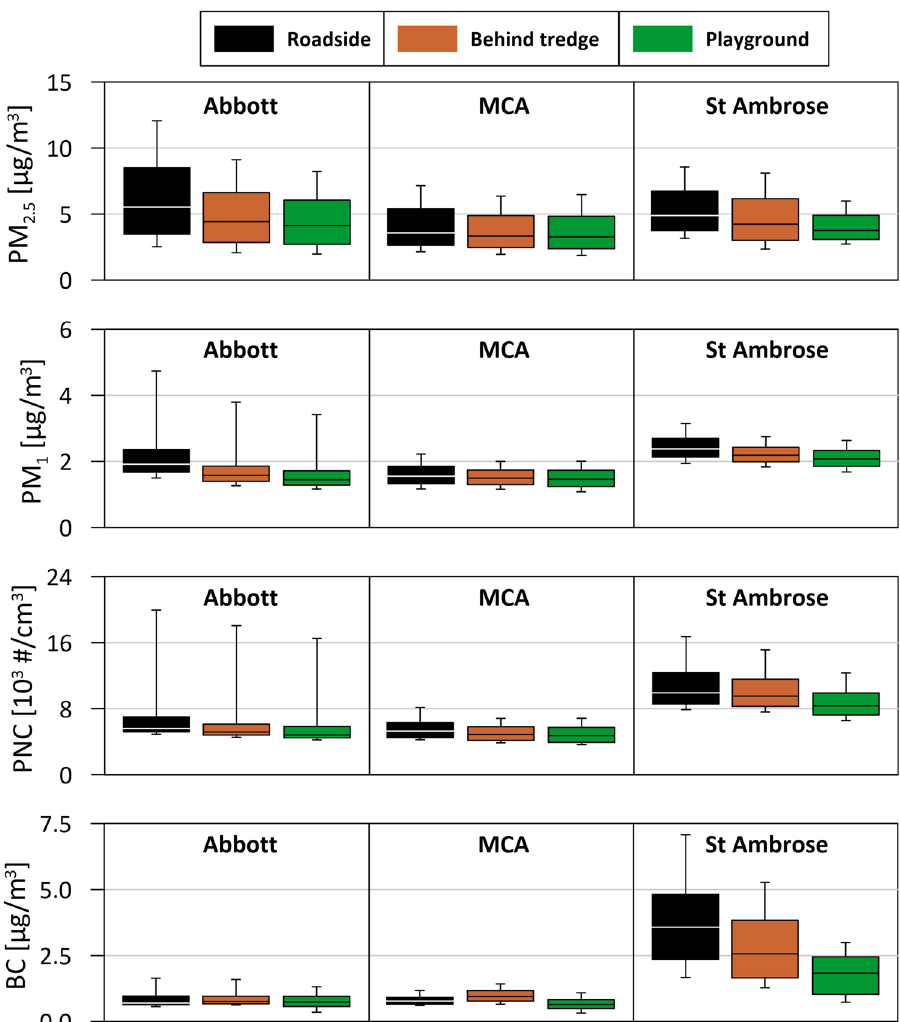
Figure 3. Black carbon (BC), PM 2.5 , PM 1 and particle number concentrations (PNCs), 1-min aves., measured at the roadsides, and in the playgrounds at 1 m (‘Behind tredge’) and ~ 5 m (‘Playground’) behind the tredges. Boxes indicate median value, lower and upper quartiles, and whiskers show 10th and 90th percentiles.